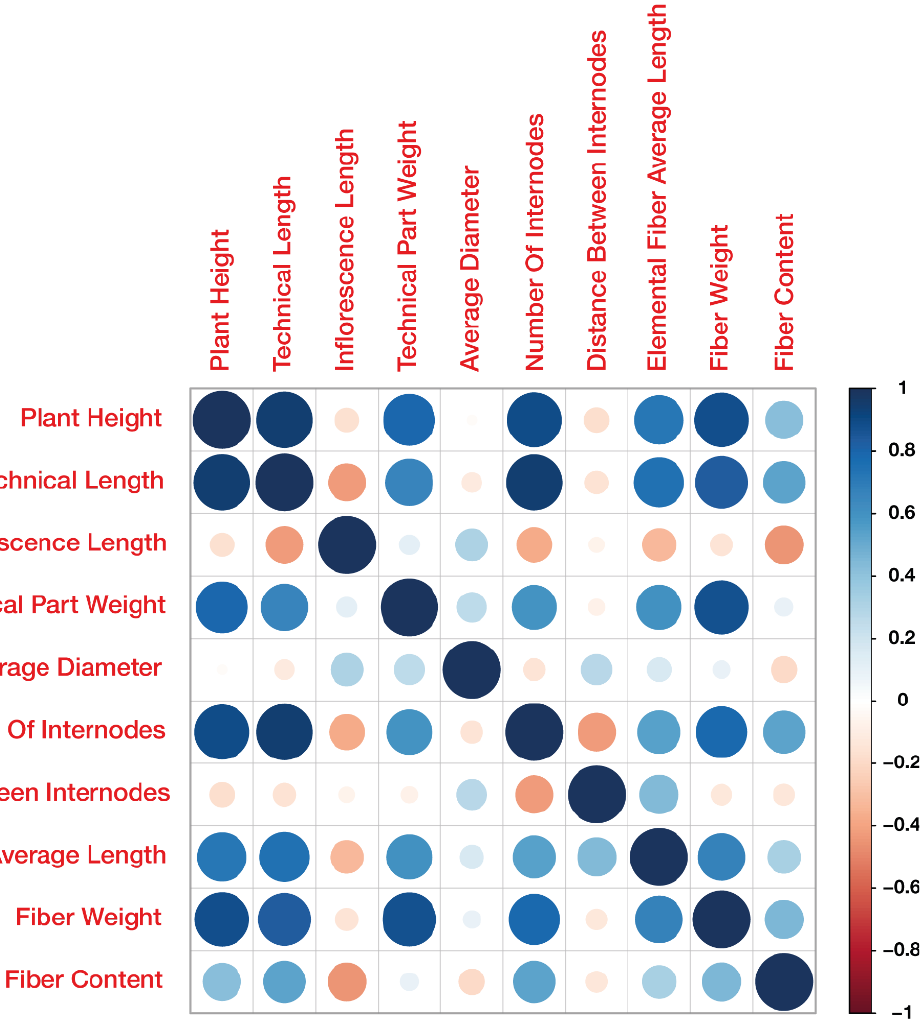
Figure 1. Pearson correlation between traits in 2019Y.